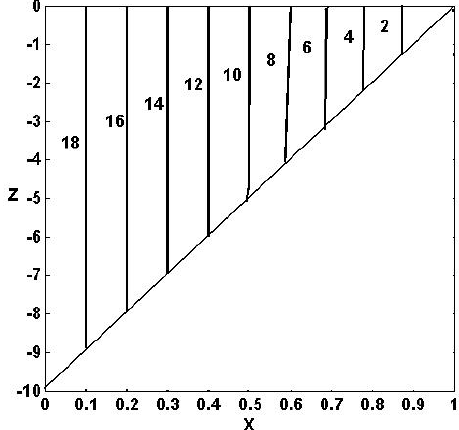
Fig. 7. Contour plot of T 1 /2 on a section of H perpendicular to the Y axis ( α = 0 . 1, V 2 = 0 .